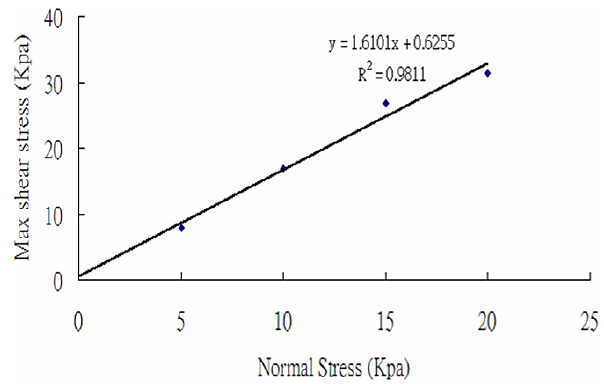
Figure 4. Shear–normal stress relation for sand.